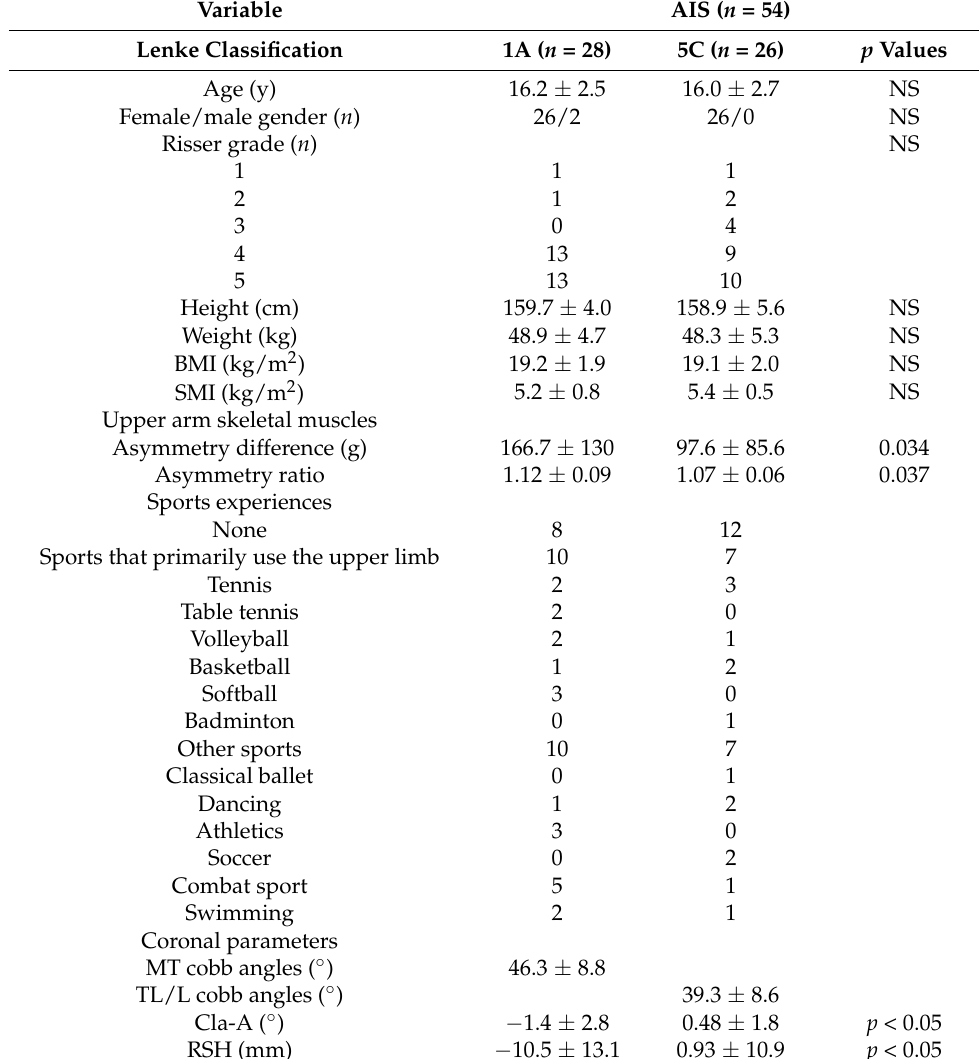
Table 1. Preoperative patient characteristics, radiographic